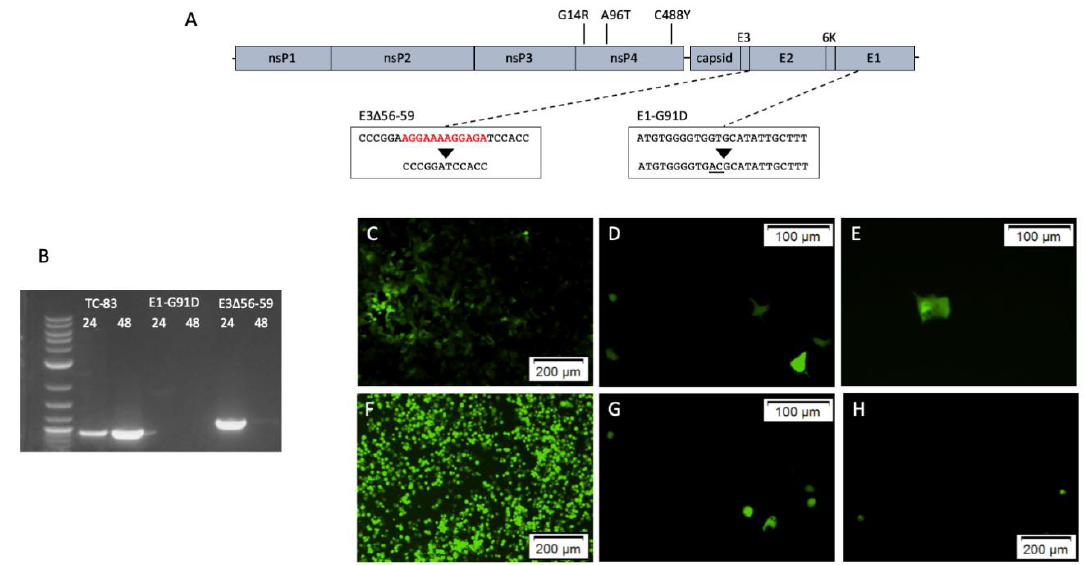
Figure 2. Mutations added to Venezuelan equine encephalitis virus (VEEV) TC-83 genome to inhibit infectivity. Schematic of the VEEV genome showing the location of the E3 ∆ 56-59 and E1-G91D mutations and mutations suspected of altering fidelity ( A ). RT-PCR of media collected from VEEV TC-83, VEEV TC-83 E3 ∆ 56-59 and VEEV TC-83 E1-G91D at 24 and 48 h post-electroporation ( B ). Fluorescent microscopy of Vero cells transfected with VEEV TC-83 GFP ( C , F ), VEEV TC-83 E3 ∆ 56-59 GFP ( D , G ) and VEEV TC-83 E1-G91D GFP ( E , H ). Panels C-E are 24 h post-transfection, F-H are 48 h post-transfection.